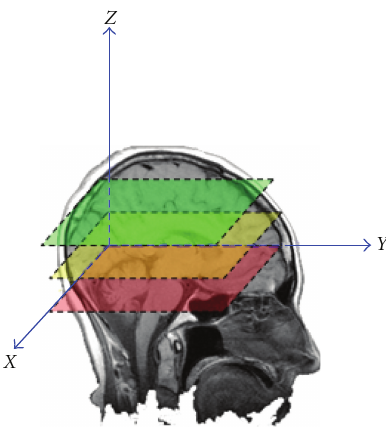
Figure 2: A carton illustrating the scanning